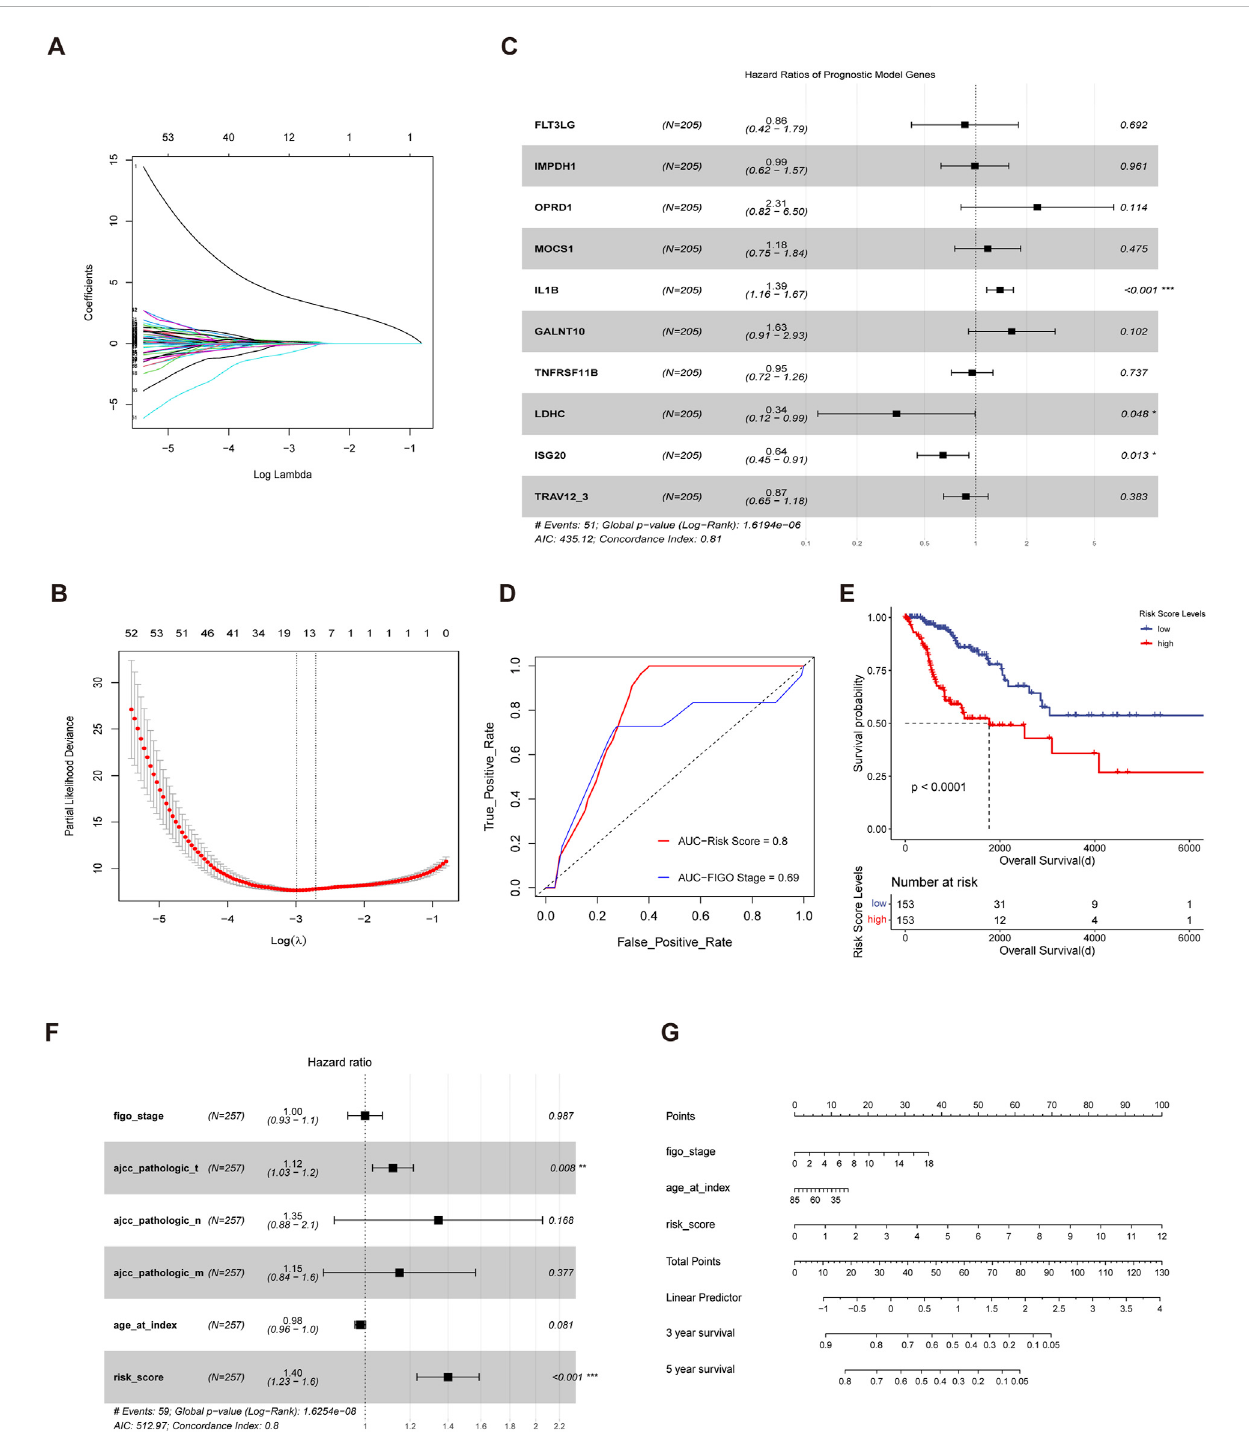
FIGURE 4 Construction of an immuno-metabolic prognostic model for cervical cancer (A,B) Fit and cv fi t plots of LASSO screen. (C) Forest plot of Multivariate cox regression model constructed based on the genes screened out from LASSO in training cohort. (D) ROC curves measuring the predictive value of risk score andclinicalstage.TheareaundertheROCcurvewas0.82and0.69fortheriskscoreandclinicalstage,respectively. (E) Kaplan-Meiercurvesofoverallsurvival between the cohorts of TCGA with low and high risk score. (F) Forest plot of the multivariate cox regression model constructed with clinical stage, age and risk score. (G) Nomogram for predicting probability of survival at 3 and 5 years in cervical